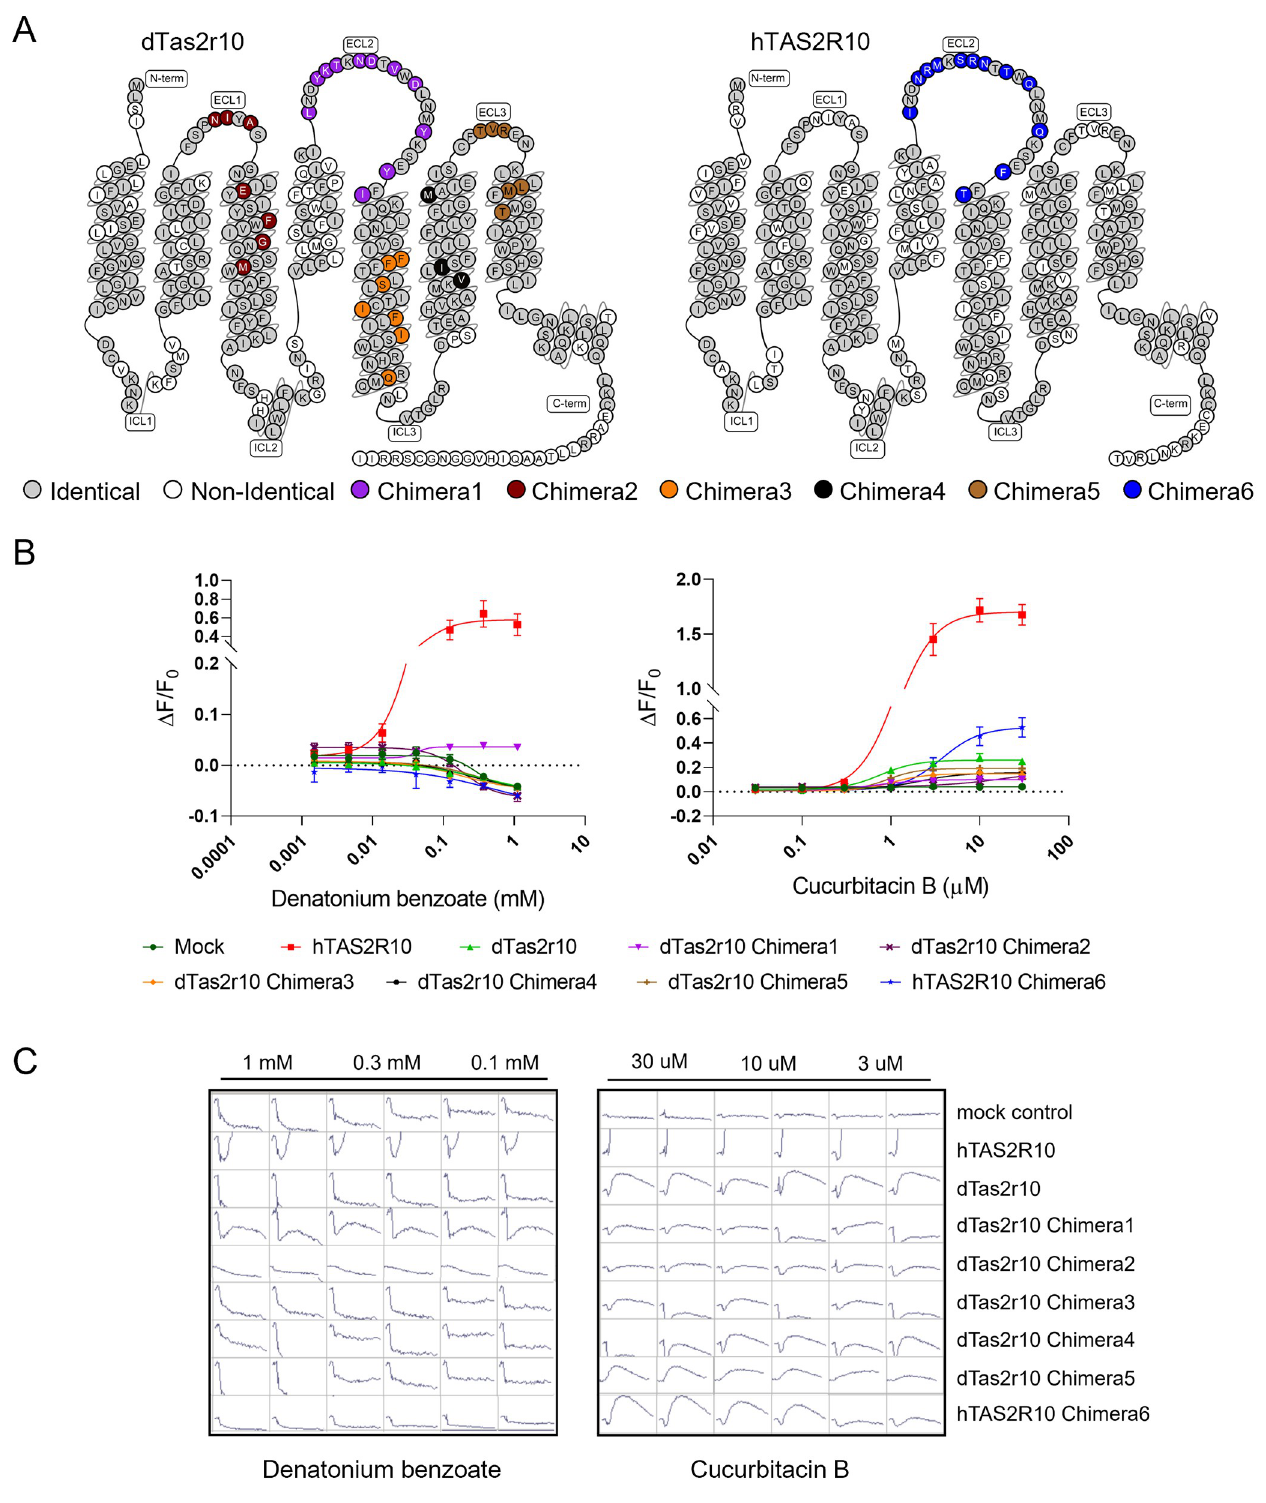
Fig 2. Calcium imaging analysis of chimeric receptors. A) Chimeras 1–5 were created with a dog Tas2r10 backbone and non-identical amino acids from different domains of hTAS2R10. Chimera6 consisted of the human hTAS2R10 backbone with the non-identical amino acids from dog Tas2r10 ECL2. B) Only native hTAS2R10 and dTas2r10 Chimera1, which contained the hTAS2R10 ECL2, responded to DB. Chimera6 (human TAS2R10 with dog ECL2) lost all